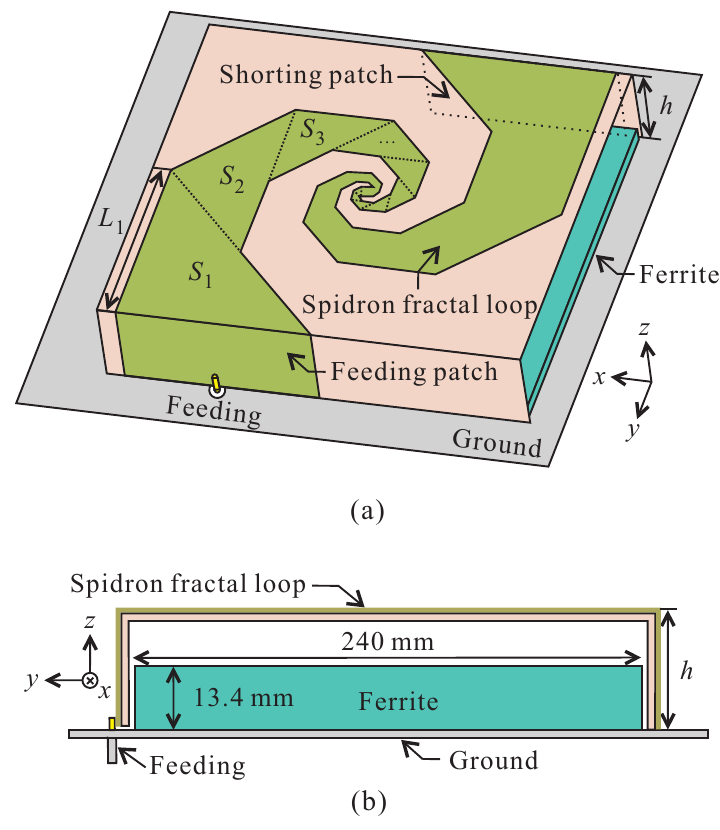
Figure 1. Geometry of the Spidron fractal loop antenna with cuboid ferrite: ( a ) 3-D view; ( b ) Side view. Table 1. Theoretical Maximum Gain of the Loop Antenna at the Lowest Frequency (30 MHz).